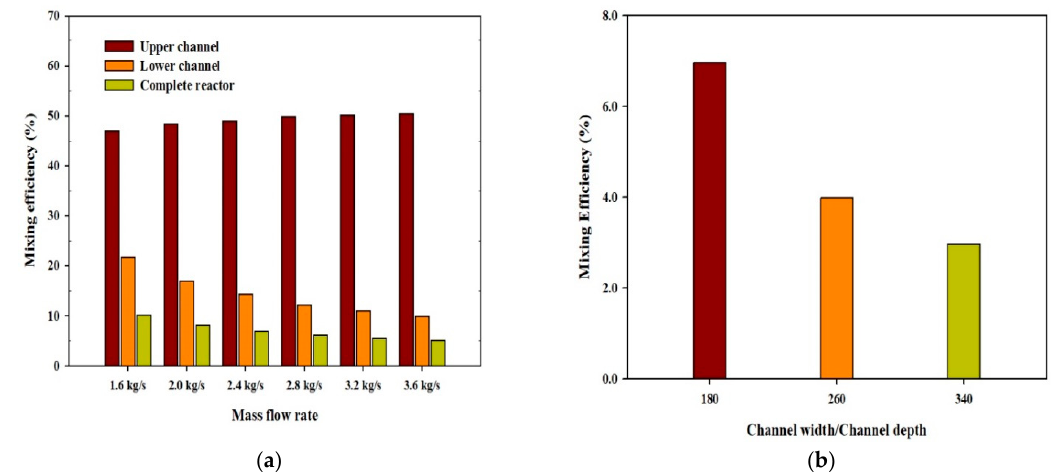
Figure 3. ( a ) Effect of mass flow rate on mixing efficiency at a water depth of 5.6 mm and slope angle of 1°. ( b ) Effect of channel width/channel depth on mixing efficiency of the complete reactor at a mass flow rate of 2.4 kg/s, water depth of 5.6 mm, and slope angle of 1°.